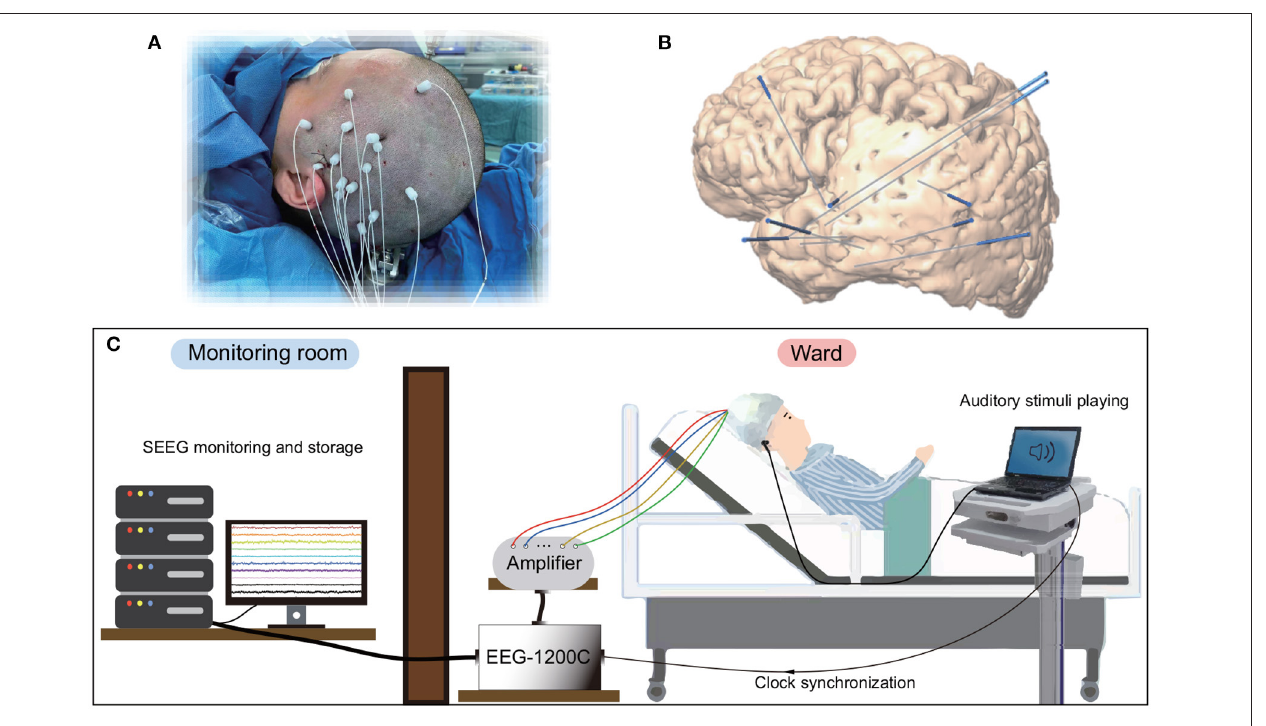
FIGURE 1 | Electrode implantation and recording environments for SEEG. (A) Surgical implantation of electrode shafts. (B) A sample of 3D brain model with implanted electrode shafts. (C) A patient and the whole recording system in a clinical